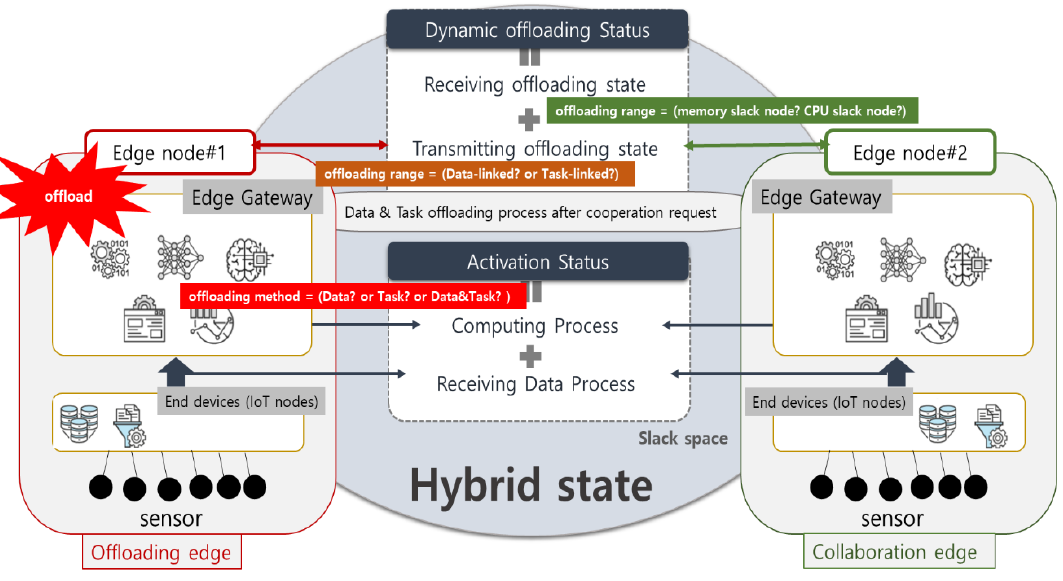
Figure 2. Monitoring process with hybrid states on edge node.